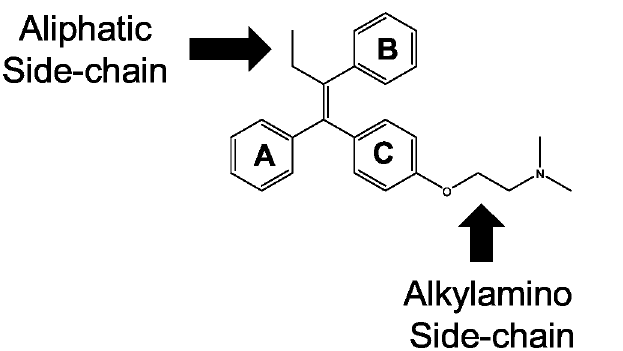
Fig 1. Structure of the tamoxifen-derived triphenylethylene scaffold with key regions of the molecule annotated.